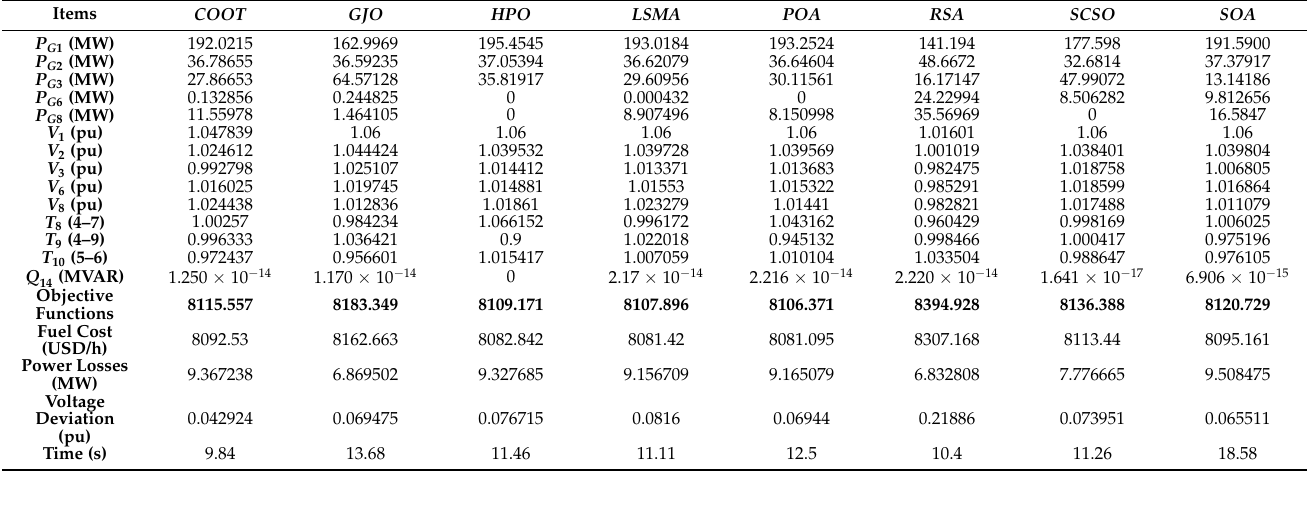
Table 5. Optimal control variables for the IEEE 14-bus test system for minimizing multi-objective function without emissions.